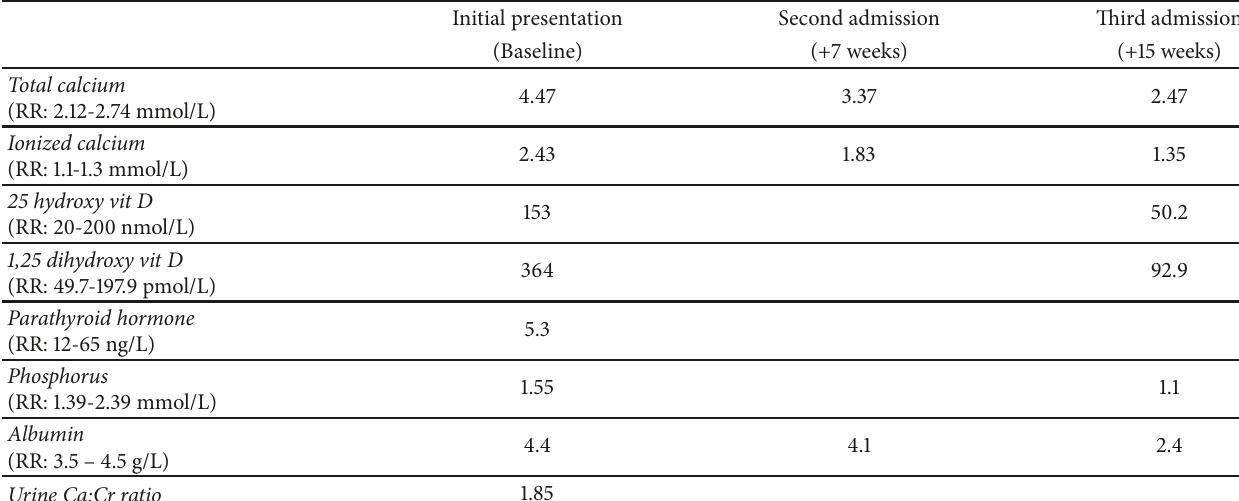
Table 1: Calcium metabolism markers at each of the hospital